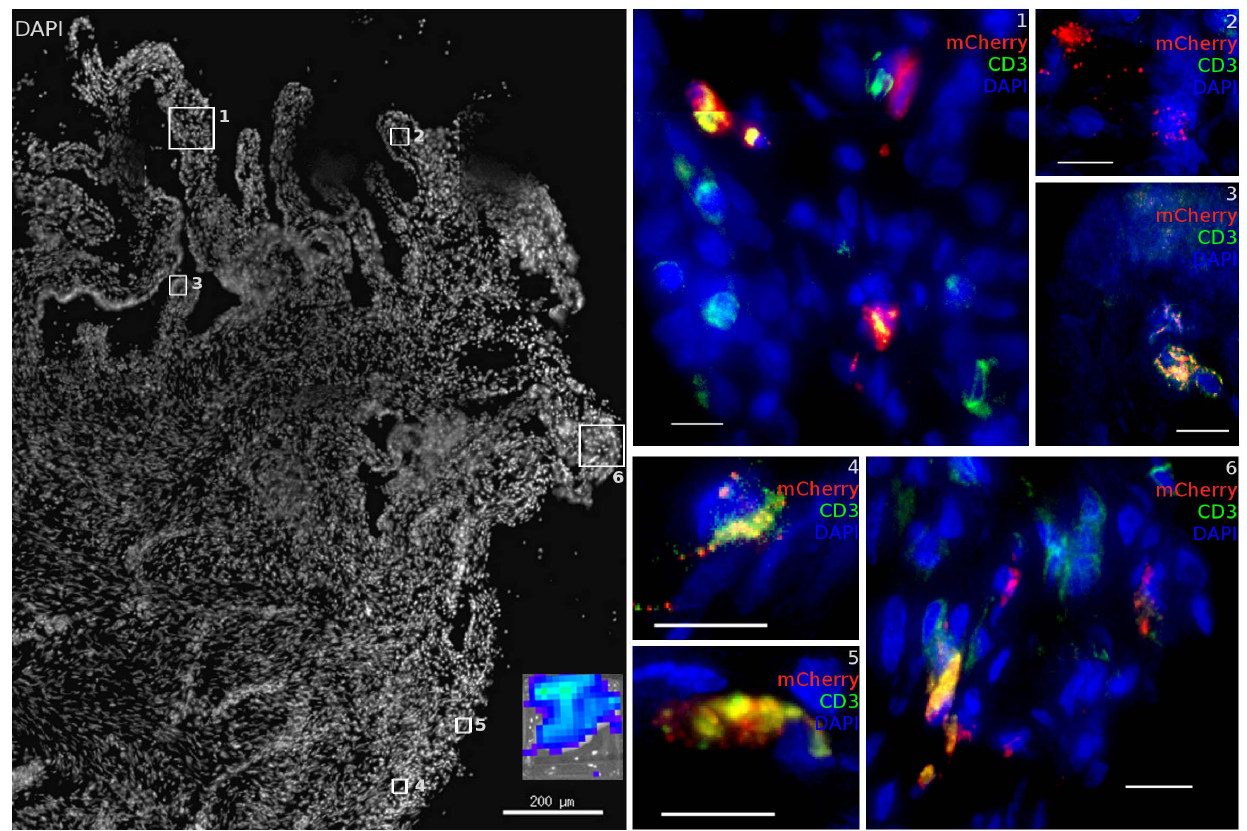
Figure 6. Diverse cell types are infected within the cervix. Within the cervix, both endocervical (Region 1–3) and ectocervical (Region 4–6) domains in the area of the transformation zone contain many resident T cells which are susceptible to infection with JRFL pseudotyped LICh vector. Non-T cells are also infected. Inset shows luciferase expression within dissected tissue before freezing. Scale bars measure 10 m m unless otherwise specified. mCherry expression (red), CD3 staining (green) and nuclei label (blue) are used to show transduced cells. (animal code: